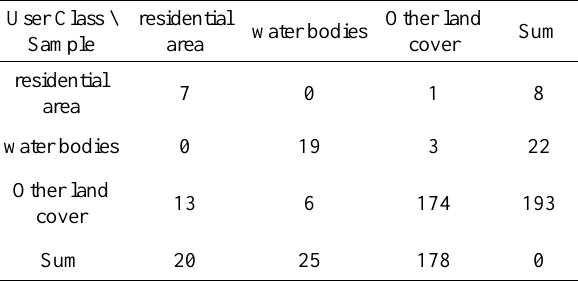
Table 3. The confusion